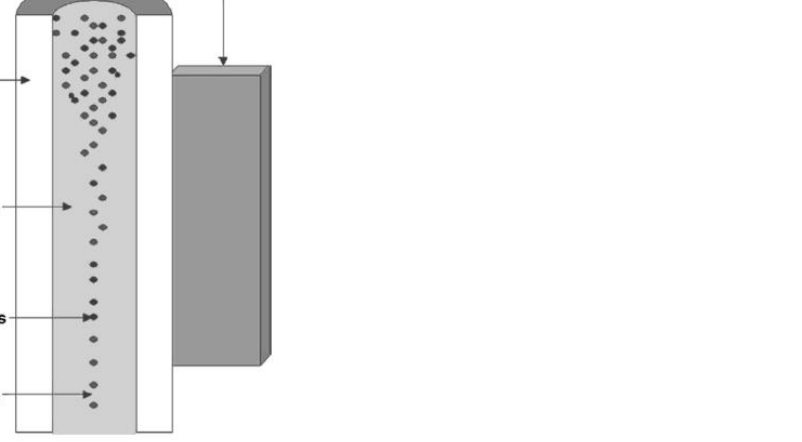
Figure 1. Glass cylindrical shell driven by a line-source piezoelectric transducer for particle concentration in a fluid medium [42].